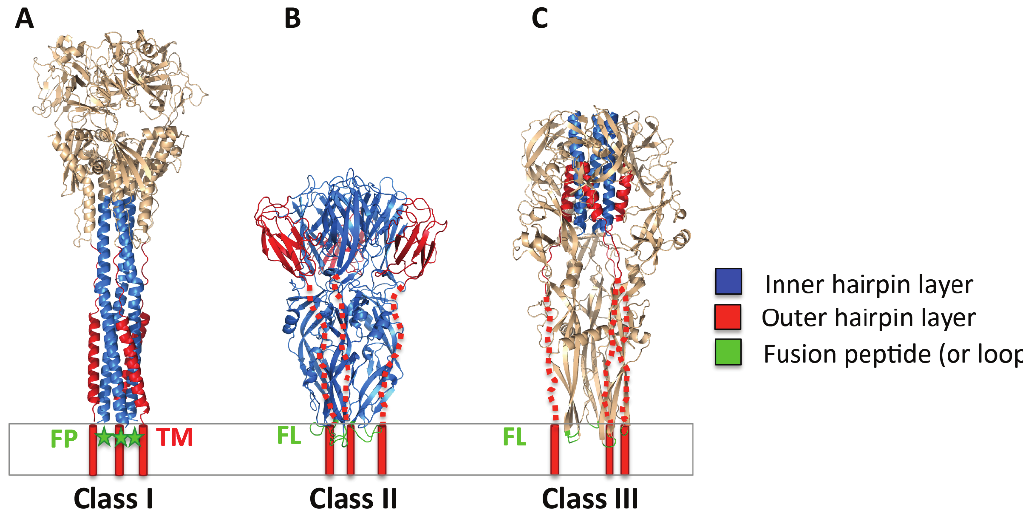
Figure 2. Postfusion structures of representative viral fusogens from each of the three known classes. Class I, PIV3 F (PDB ID 1ZTM); class II, Dengue E (PDB ID 1OK8), class III, VSV G (PDB ID 2CMZ). The inner and outer layers of the postfusion hairpin are shown in blue and red, respectively. Fusion loops (FL) of Dengue E and VSV G are shown in green. The fusion peptide (FP) of PIV3 F, missing from the structure, is indicated with a green star. The extended C-terminal segments in Dengue E and VSV G, unresolved in the structures, are shown as dashed red lines. The TM segments are represented by red cylinders. The membrane is shown schematically. Figure was made with Pymol.